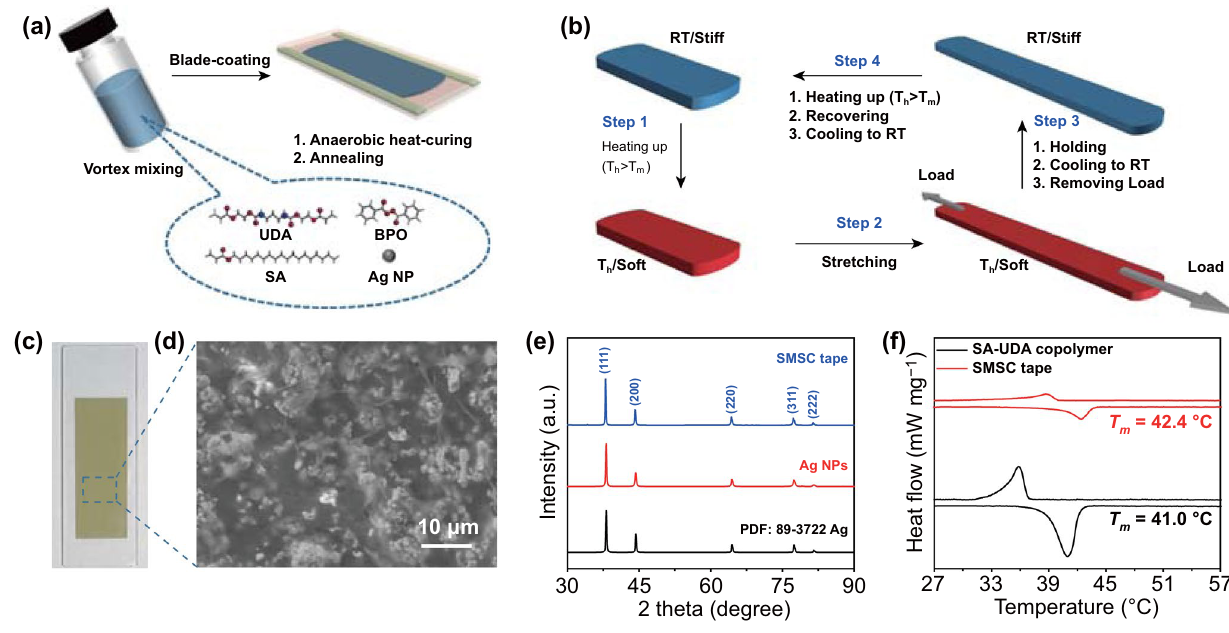
Fig. 1 Preparation and Characterization of SMSC tape. a Schematic illustration of the preparation process. b The shape memory effect of SMSC tape. c Optical image of as-prepared SMSC tape. d Cross-sectional morphology of SMSC tape. The scale bar is 10 μm. e XRD pat- terns of Ag NPs, SMSC tape and the powder diffraction file (PDF) of 89–3722 Ag. f DSC diagrams of SMSC tape (red line) and pure SA-UDA copolymer (black